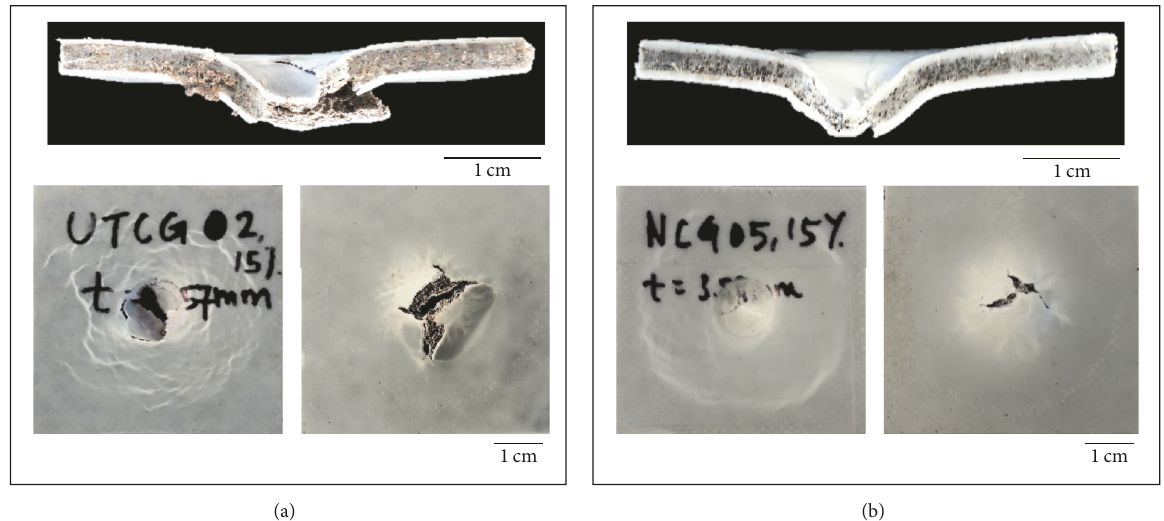
Figure 10: Fracture surface of impact test: (a) composite type B3 and (b) composite type D3.